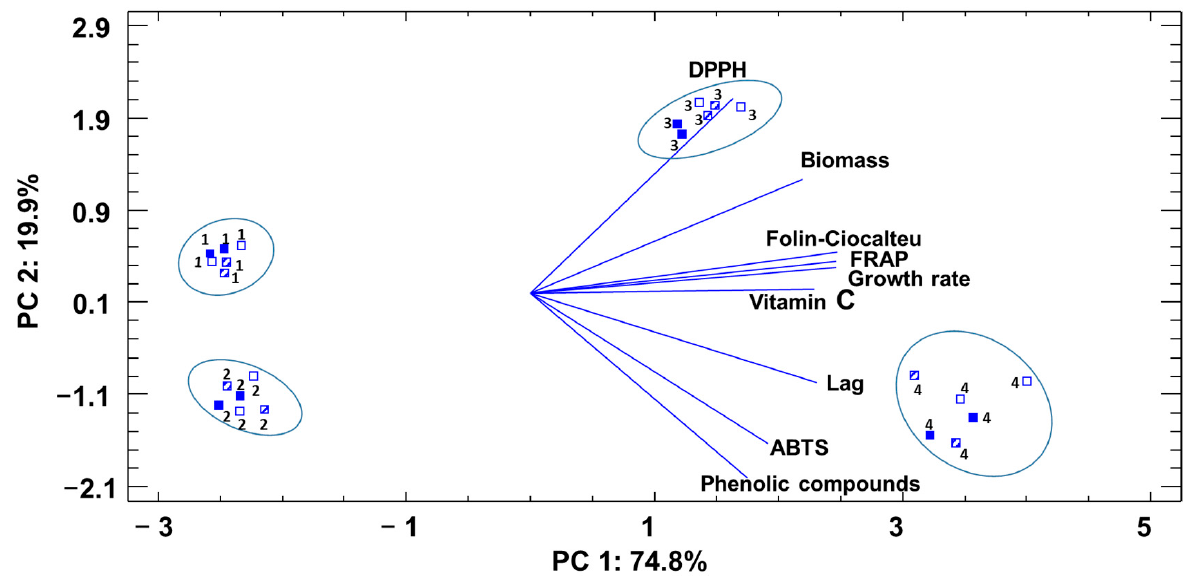
Figure 2. Plot of scores and loadings for two principal components (PC1, PC2) of untreated and treated fruit juices: (1) tomato, (2) apple, (3) pineapple and (4) orange juice. Treatments: fresh ( □ ), HIPEF-treated ( ) and thermally-treated juices ( ).